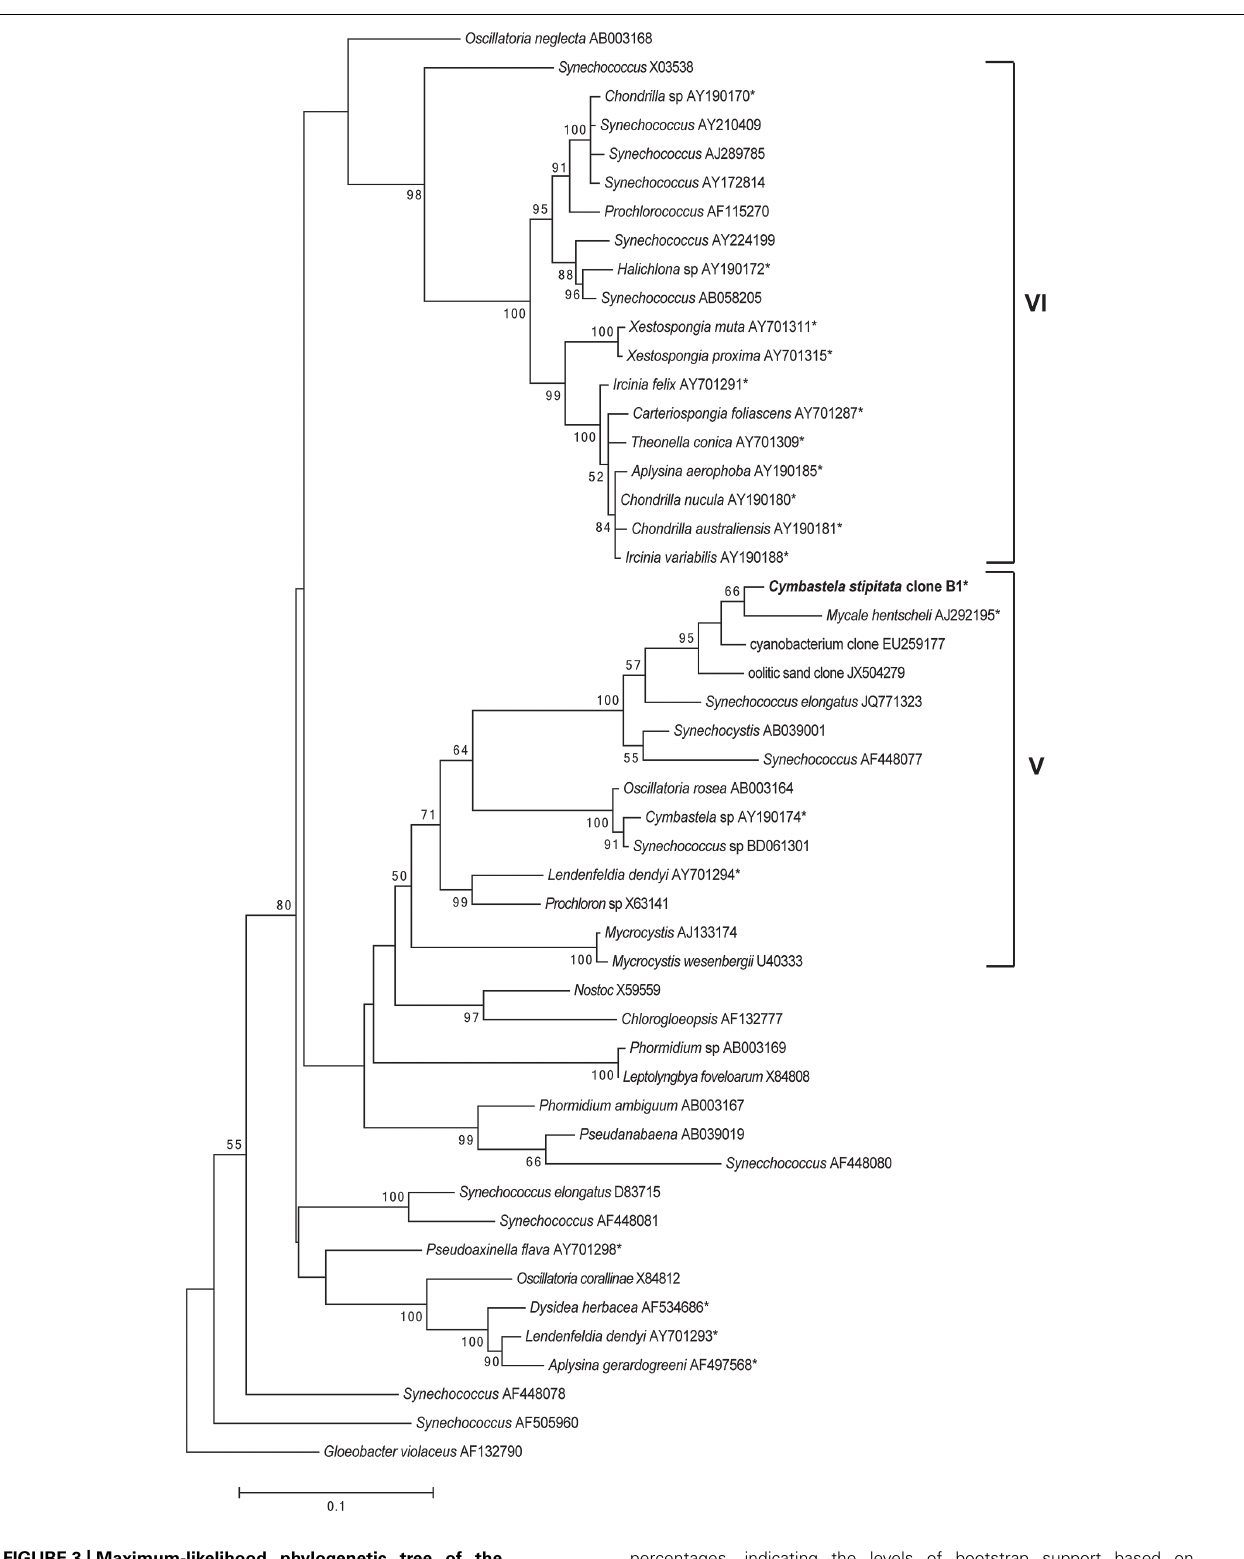
percentages, indicating the levels of bootstrap support based on analysis of 500 resampled data sets. Only values > 50% are shown. The scale bar represents 0.1 substitutions per nucleotide